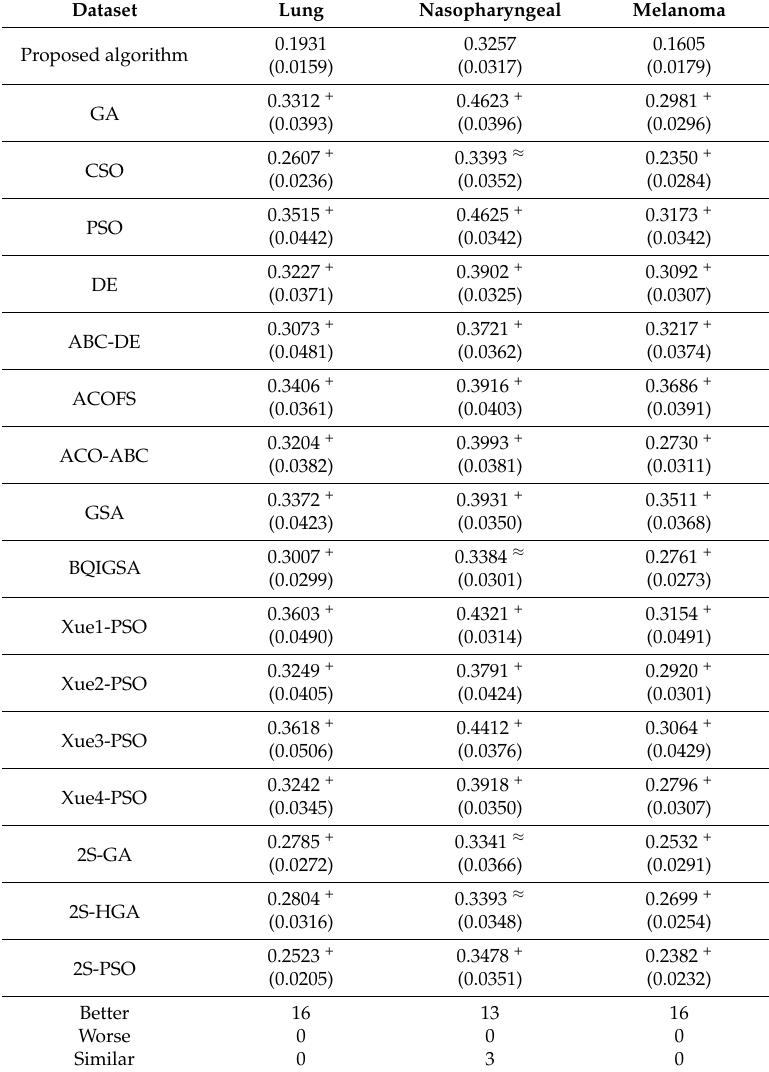
Table 2. Average error rate of different algorithms in cancer